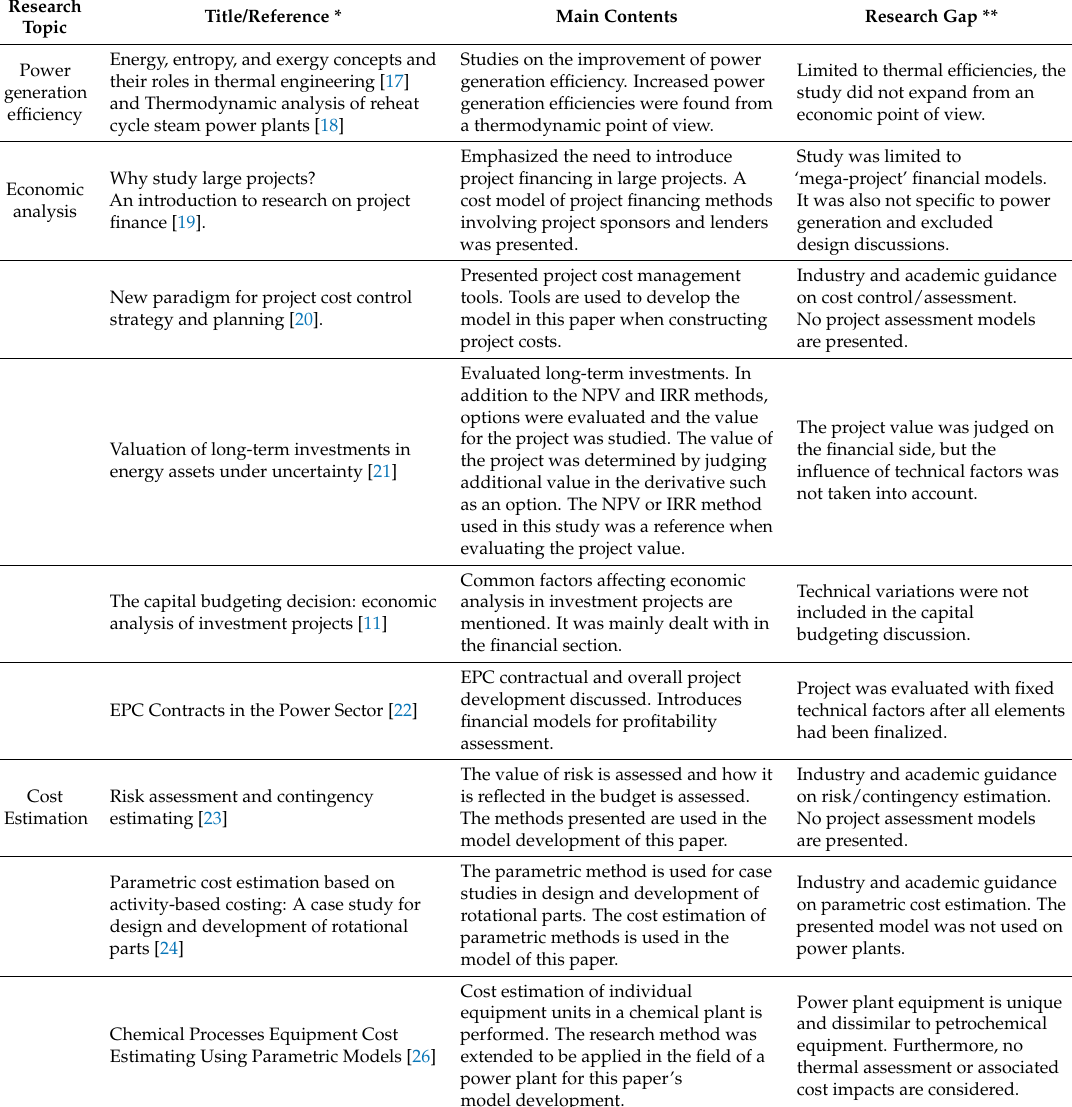
Table 1. Existing literature review